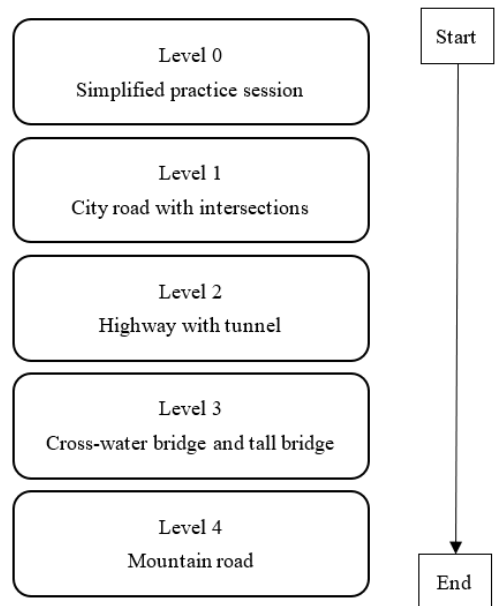
Figure 2. The five-level driving scenarios.